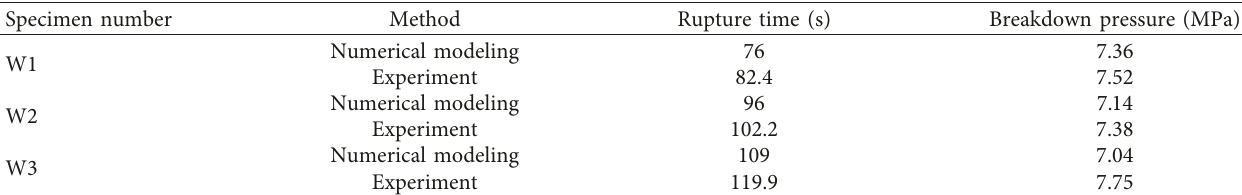
Table 5: The numerical and experimental values of rupture time and breakdown pressure (water fracturing).